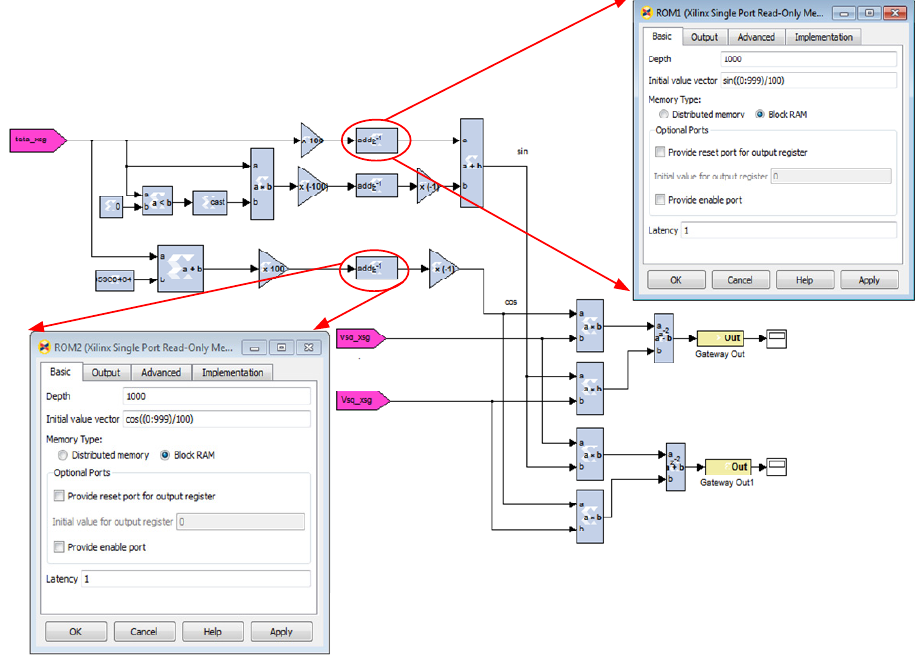
Figure 13. XSG modeling of the coordinate transformation (d,q) to ( , ) α β using ROM blocks.